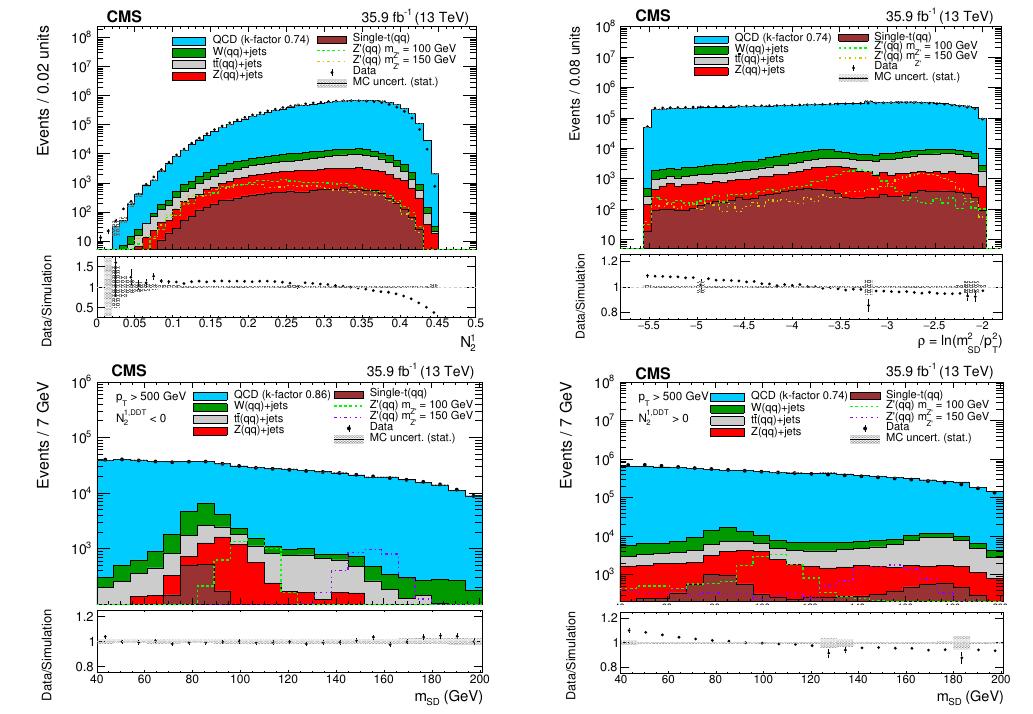
Figure 9 . Distributions of data (points) and simulated backgrounds (histograms) of the leading p T jet N 1 (top left) and (cid:26) (top right) observables, after the kinematic selection. The soft-drop jet 2 mass distributions for the passing (bottom left) and failing (bottom right) region, de(cid:12)ned by the N 1 ; DDT selection, are also shown. The decorrelation ensures that the shape of the multijet mass 2 distribution in both regions is una(cid:11)ected by the N 1 ; DDT selection for di(cid:11)erent p T ranges. Dashed 2 lines illustrate the signal contribution for di(cid:11)erent Z 0 boson masses. The multijet processes (QCD) dominate the background component, with subdominant contributions from inclusive SM W, Z, and tt and single top quark processes. The QCD simulation is scaled by an overall factor of 0.74 to match the data yield. Residual di(cid:11)erences between data and simulation demonstrate the need for a background estimation method based on control samples in